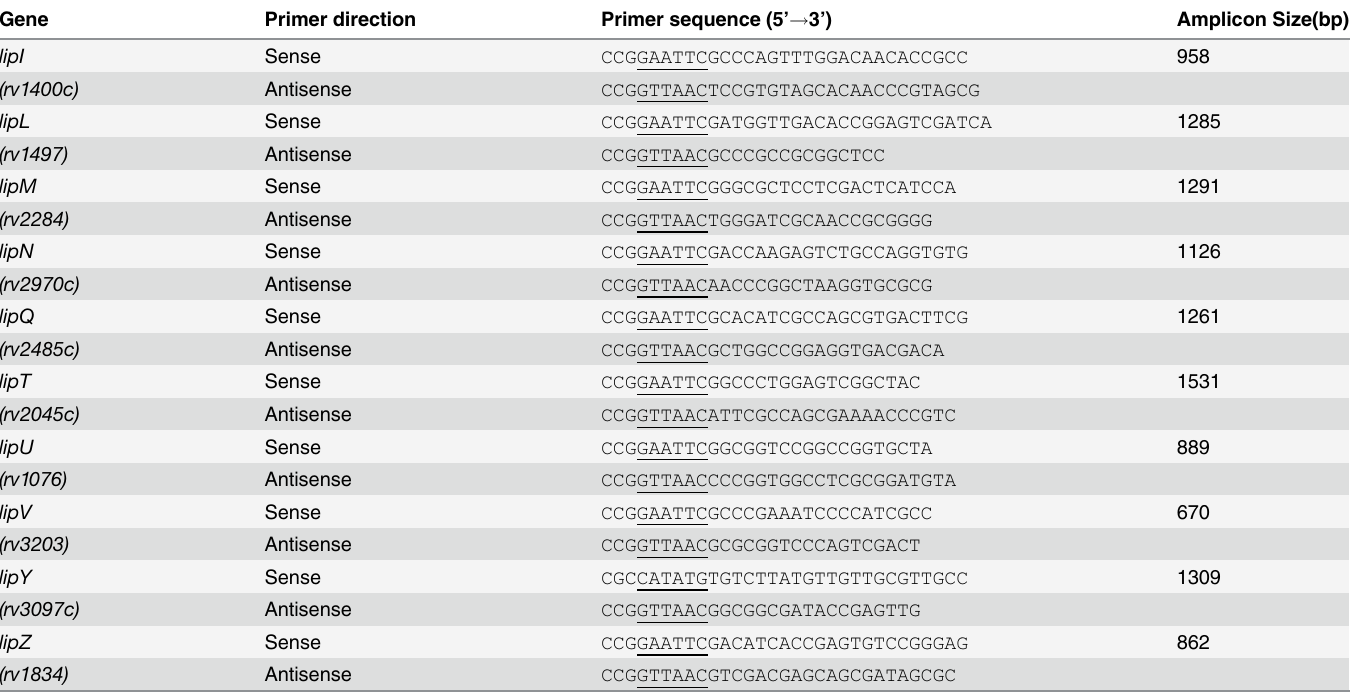
Table 2. Primers used for PCR of 10 Lip family genes from M . tuberculosis .